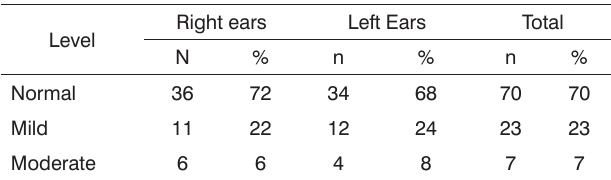
Table 6. Audiometric test results for right and left ears; patients in the control group (DM-free subjects) according to hearing loss level - Davis & Silvermann 24 .